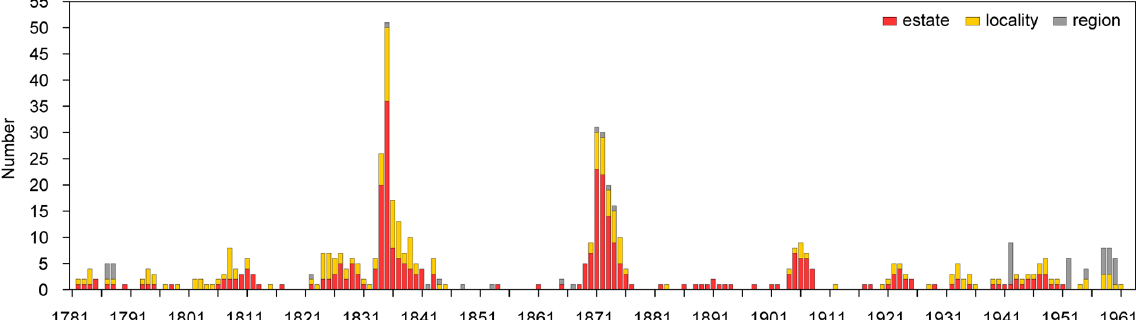
Figure 1. The annual numbers of locations with bark beetle outbreaks over the territory of the Czech Republic during the 1781–1963 period extracted from documentary